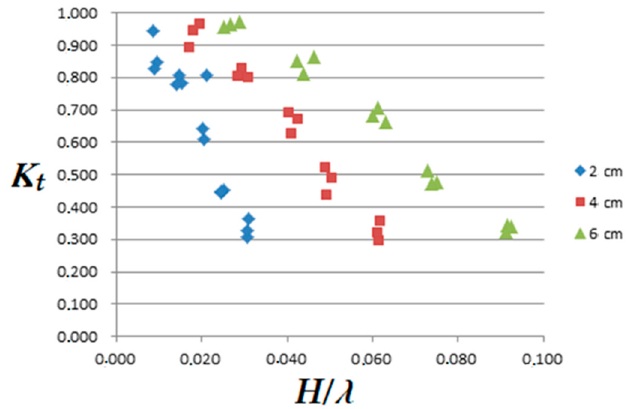
Figure 6. The relationship between the steepness of the wave and the transmittance of the latex plate fixed at both edges, water depth a = 0.3 m.